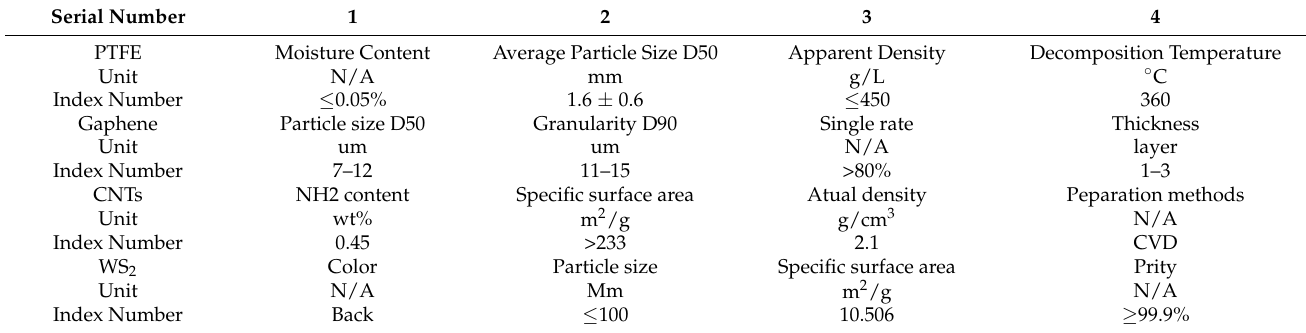
Table 2. Lubrication additive properties.